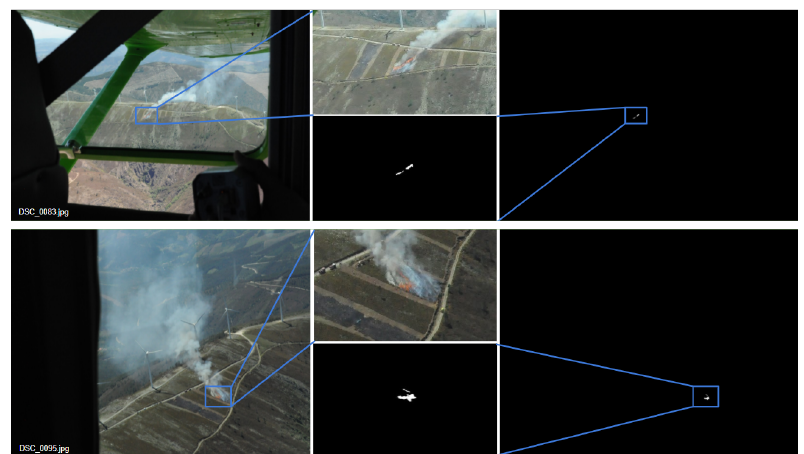
Figure 5. Two examples of fire segmentation of the proposed method for aerial images containing a small portion of fire. ( Left ): Original images; ( Right ): Segmented masks by Q + C + S; ( Middle ): Magnified images and obtained masks.